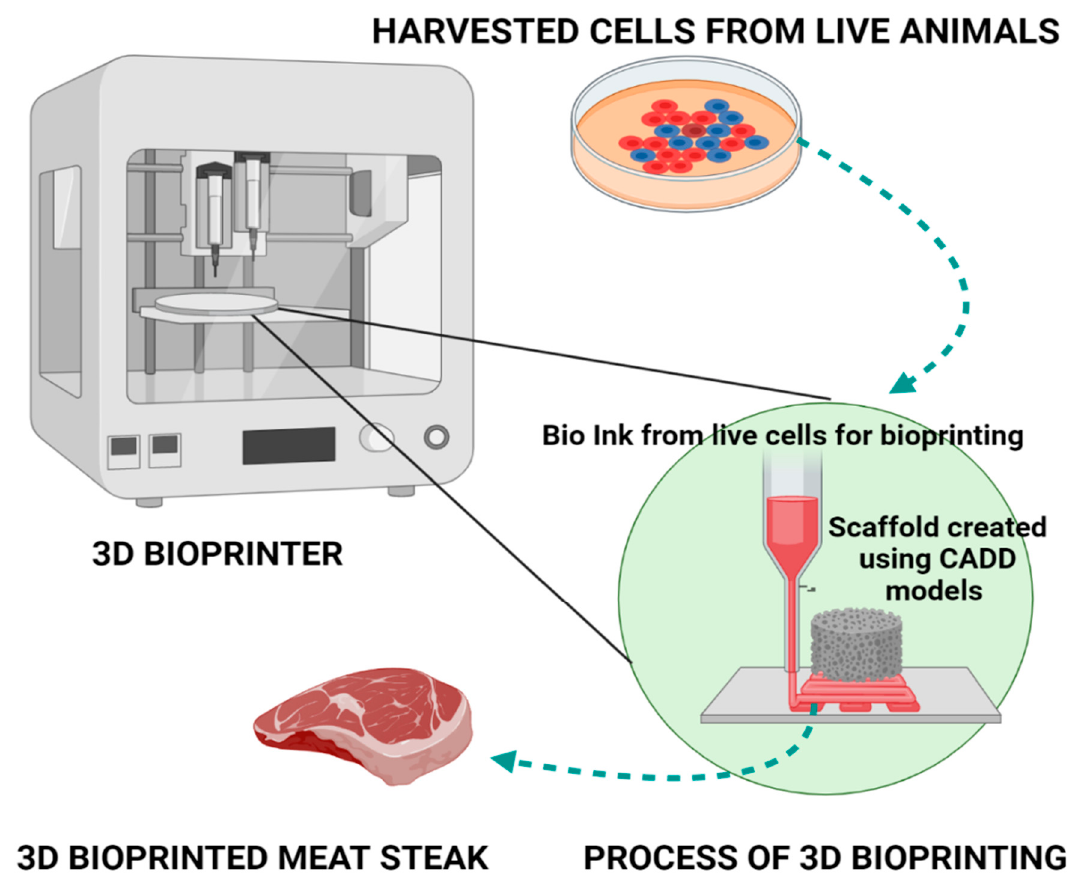
Figure 4. The trans-disciplinary application of 3D bioprinting in in vitro culture meat technique.